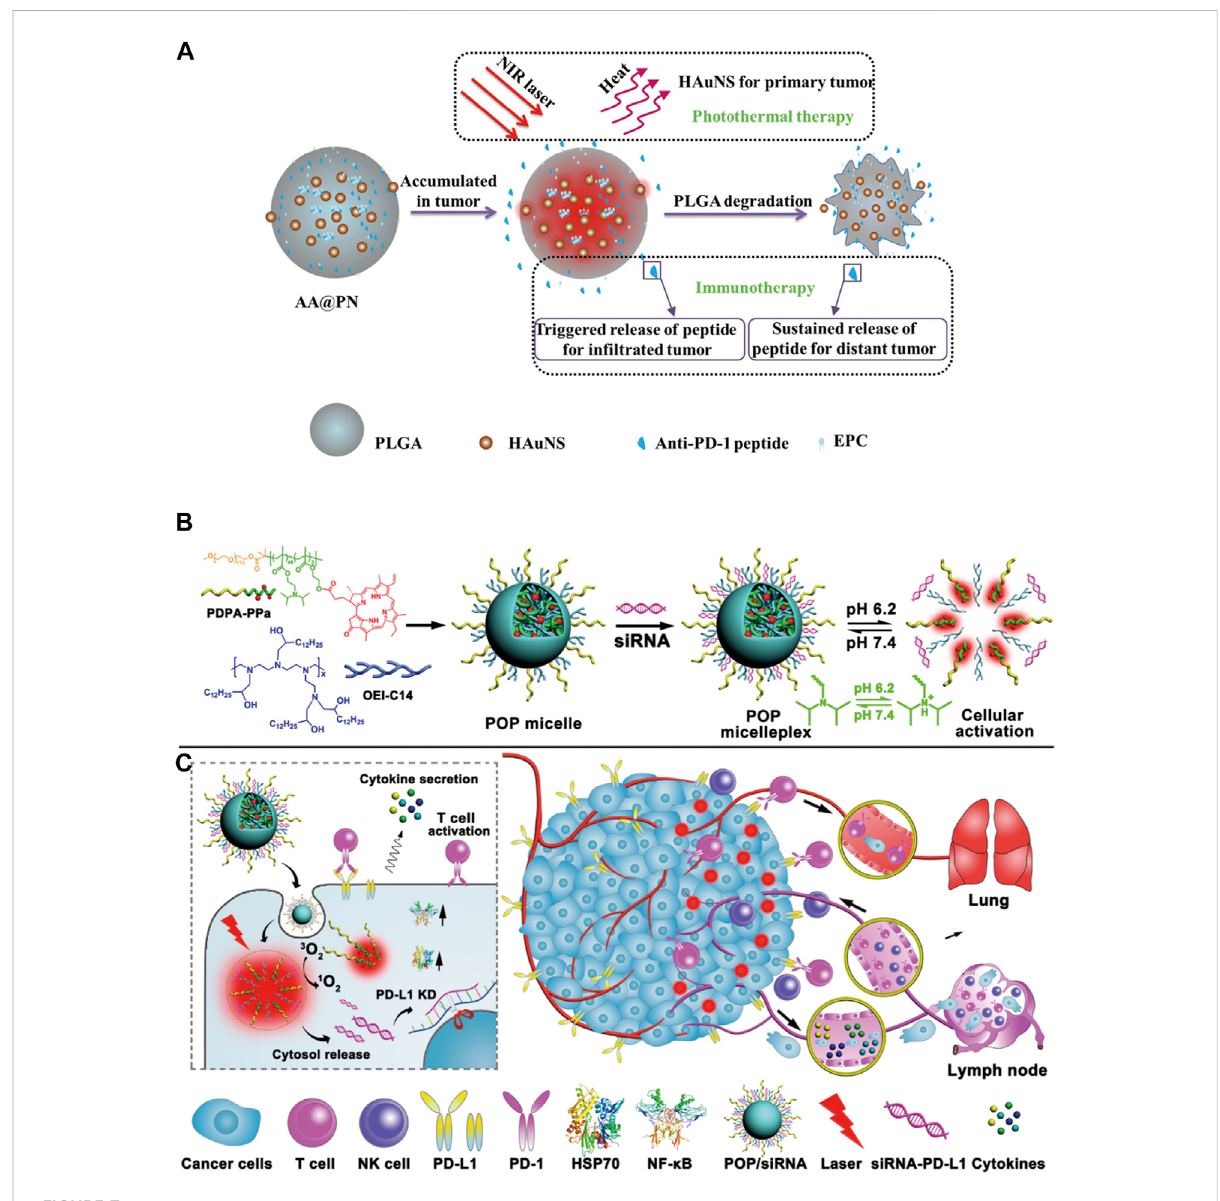
FIGURE 7 (A) Scheme showing the preparation and structure of AA@PN as well as its combined therapeutic modalities (Luo et al., 2018). (B,C) Cartoon schematic of POP − PD-L1 micelleplex mediated photodynamic cancer immunotherapy (Wang et al.,